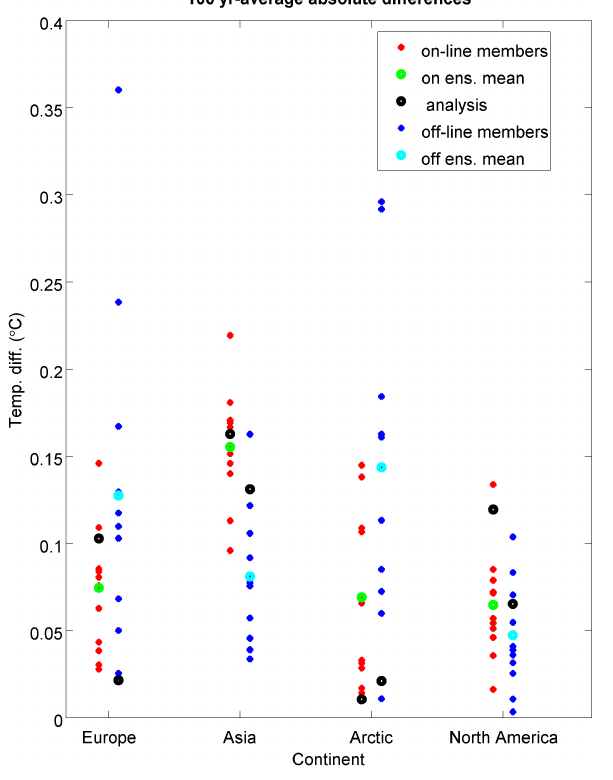
Figure 6. Absolute differences between simulated and recon- structed 17th century average temperatures, for the on-line (red dots) and off-line (blue dots) ensemble members, the on-line (green dots) and off-line (cyan dots) ensemble means, and the two analyses (black dots).